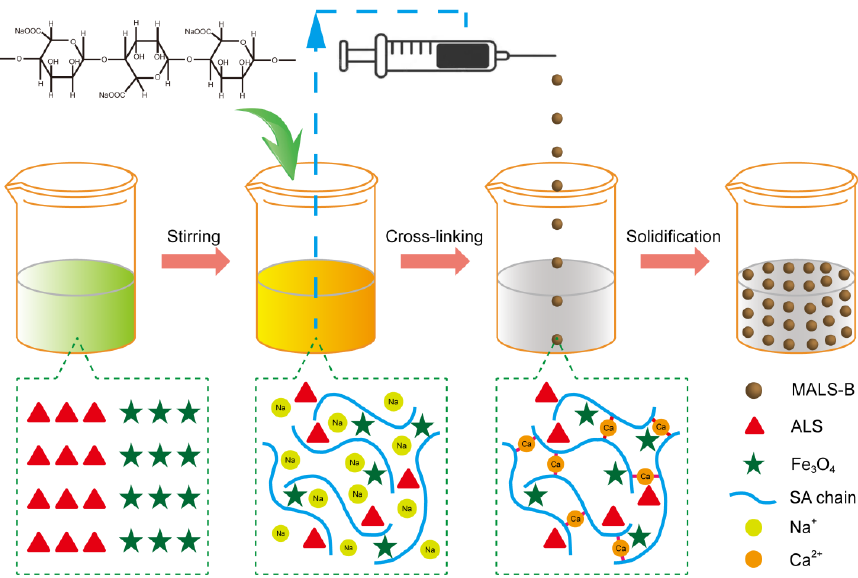
Figure 1. Schematic illustration for the synthesis of MALS-B.